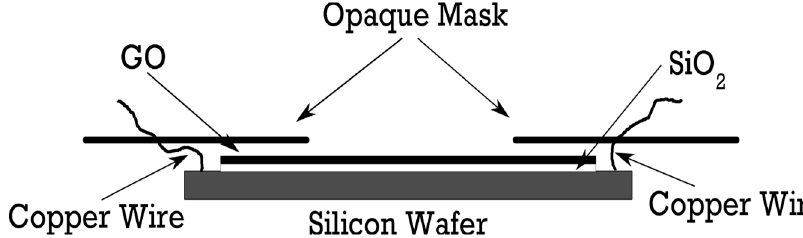
Figure 1. Scheme of the sample cell.